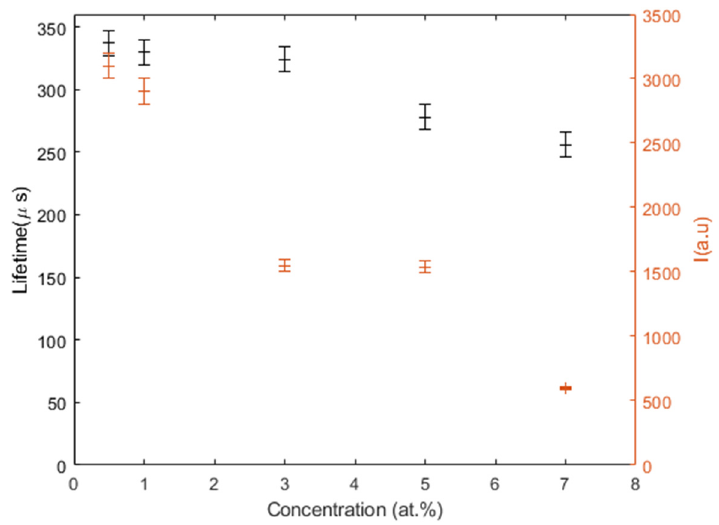
Figure 5. Lifetime of Nd:Sc 2 O 3 (black, left axis) and emission intensity (right, red axis) as a function of the doping level.